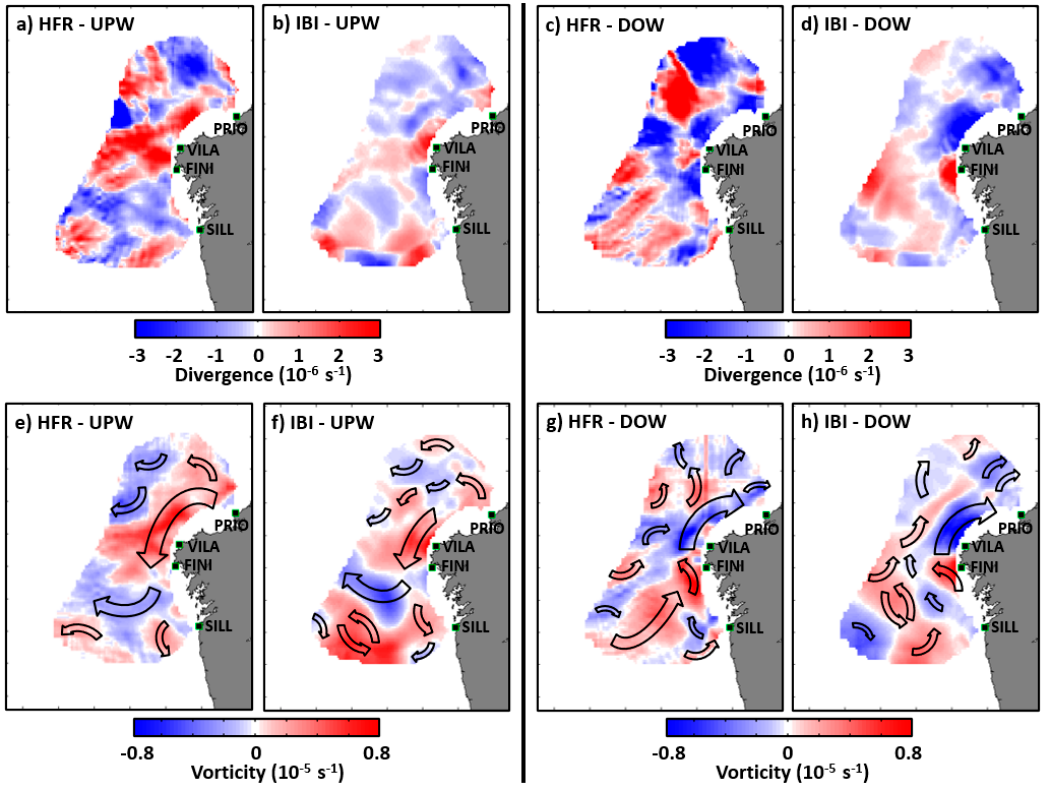
Figure 5. Ten-day averaged maps of horizontal divergence ( a – d ) and vorticity ( e – h ) derived from HFR and IBI model estimations during the upwelling (UPW) and downwelling (DOW) events. In lower panels ( e – h ), black arrows show a schematic representation of the mean circulation during the analyzed episodes.